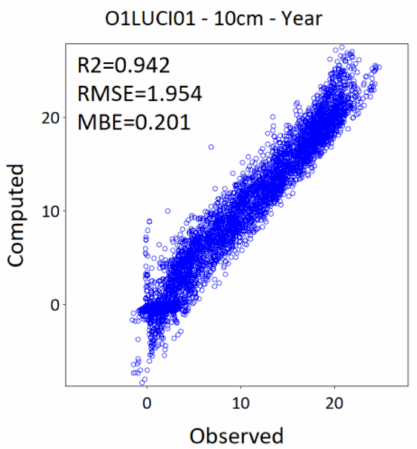
Figure A11. Validation at site O1LUCI01 for 10 cm soil